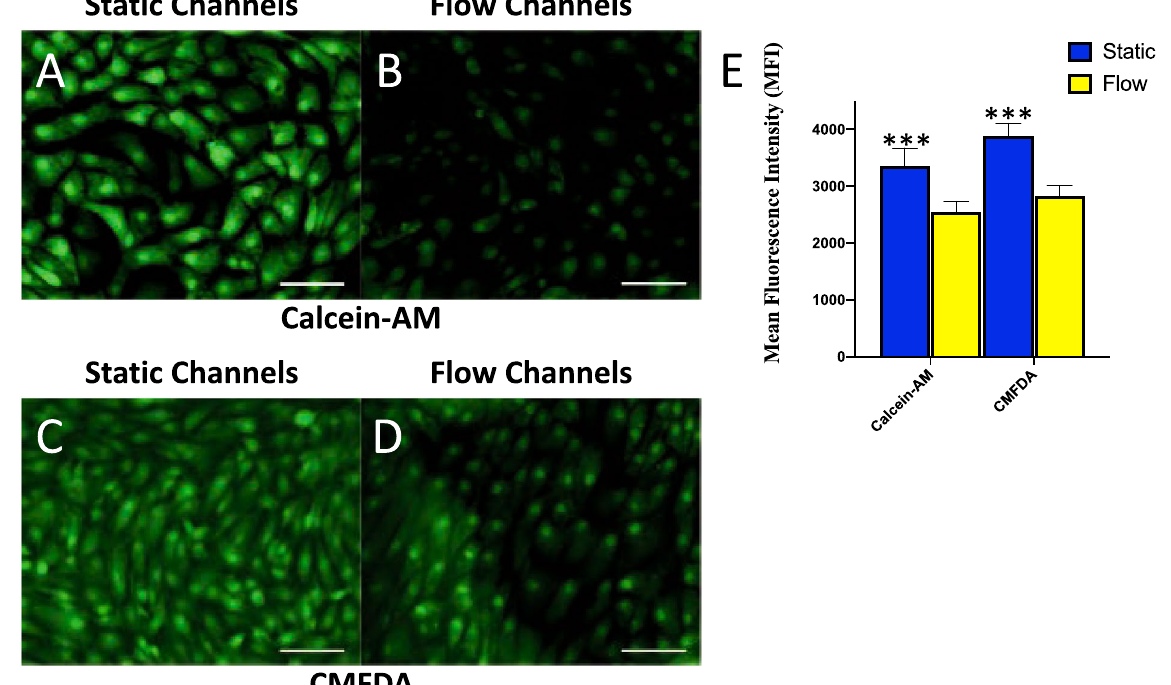
Figure 7. Fluorescent transporter substrate Calcein-AM and CMFDA amasses in RPTEC/TERT1 cells under static conditions and dissipates with the application of FSS. Figure ( B ) and ( D ) sample fluorescence images demonstrate decreased in Calcein-AM and CMFDA accumulation in cells after 24 h of FSS treatment prior to staining compared to static channels ( A and C ) (Bar = 100 µm). ( E ) Quantitative analysis of Mean Fluorescence Intensity (MFI) of Calcein-AM showed a significant decrease after cells were treated with 24 h of FSS versus static environment (yellow filled bars). Indicating the increased efflux activity after being kept under fluidic conditions (Bar = 100 µm; n = 4, ***p ≤